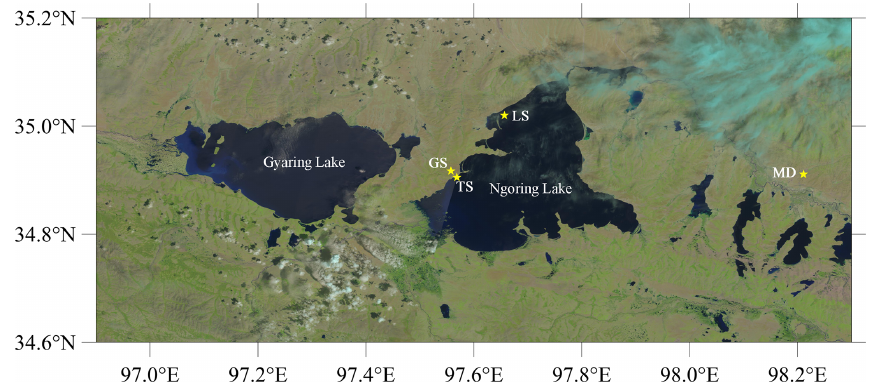
Figure 1. Map of the study area obtained using Landsat data on 21 August 2014, with the location of the observation stations marked by yellow stars. The turbulent fluxes were measured at LS and GS stations. The standard atmospheric variables were observed at TS. MD is a fixed meteorological observatory of the China Meteorological Administration.